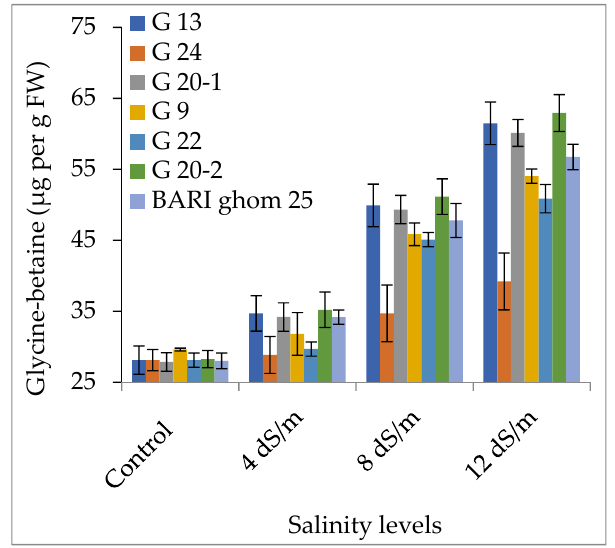
Figure 11. Glycine-betaine content in leaf of wheat genotypes under various salinity levels. The vertical bar indicates average data of five independent replicates ( n = 5). Error bars represent standard error.